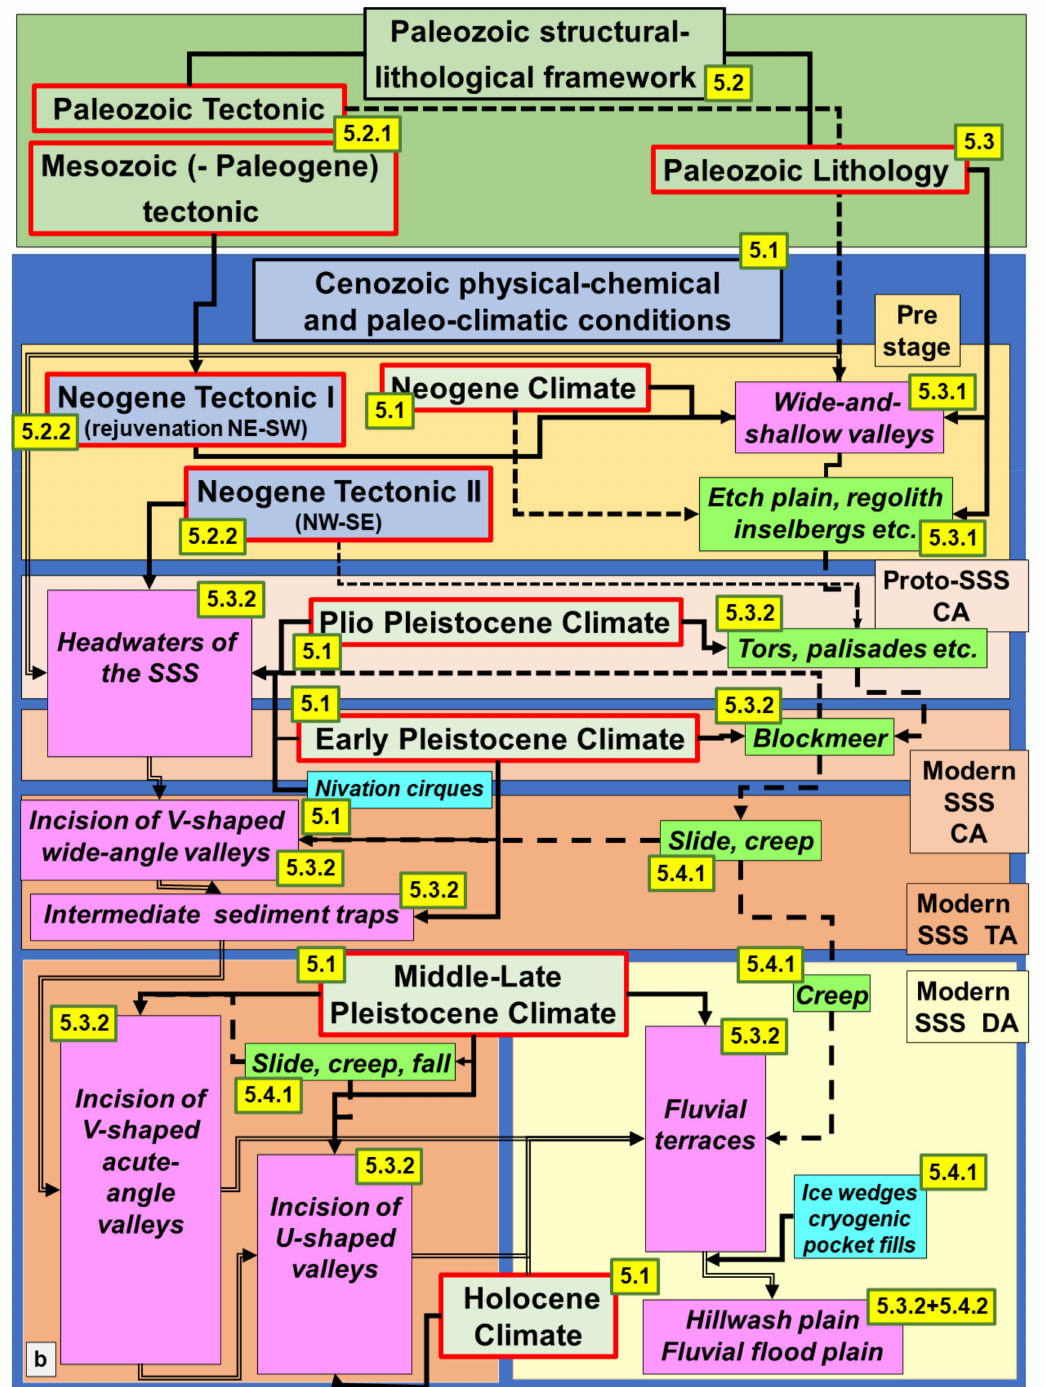
Figure 2. Flow charts of the holistic-modular approach taken to study the SSS in a basement landscape. It is a dual-use approach flow chart placing emphasis on the methodology ( a ) and the origin of the SSS ( b ) with the land-forming processes linked by color codes. ( a ) The flow chart to link methods (descriptive diagnosis -upper part, processes center part, numerical methods lower part): Multicolored boxes: processes relevant for the SSS (see also color code in ( b )); White boxes: Methods; Green boxes: Tools and products; Yellow boxes/framed in dark green with Arabic numerals reference to “Results”. ( b ) The genetic flow chart to link genetic parameters as a function of evolutionary stages (framework, prestage, proto-SSS/CA, modern SSS/CA, modern SSS/TA, modern SSS/DA): Multicolored boxes: processes relevant for the SSS (see also color code in ( a )); Blue boxes framed in red: Tectonic drivers and their age of operation; Beige boxes framed in red: Climatic drivers and the age of operation; Yellow boxes/ framed in dark green with Arabic numerals reference to